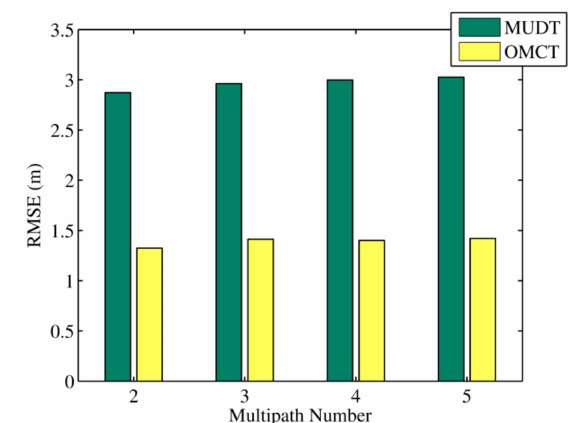
Figure 3. The RMSEs of the multipath-distinguishing-based trilateration positioning algorithm (MUDT) and OMCT under di ff erent multipath numbers in the experiment.